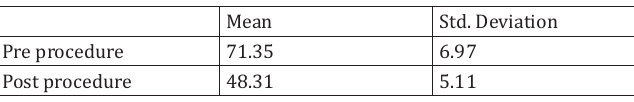
DASH Score showed mean difference of 23.04